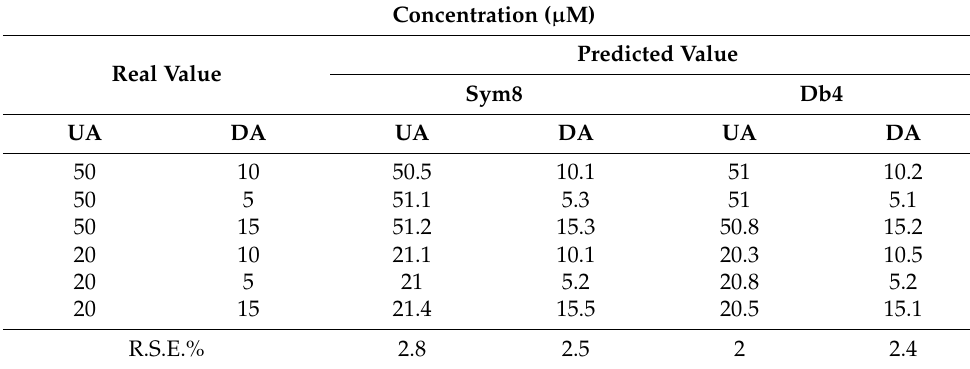
Table 3. Estimated concentration and R.S.E values of DA and UA predicted by CWT-sym8 and